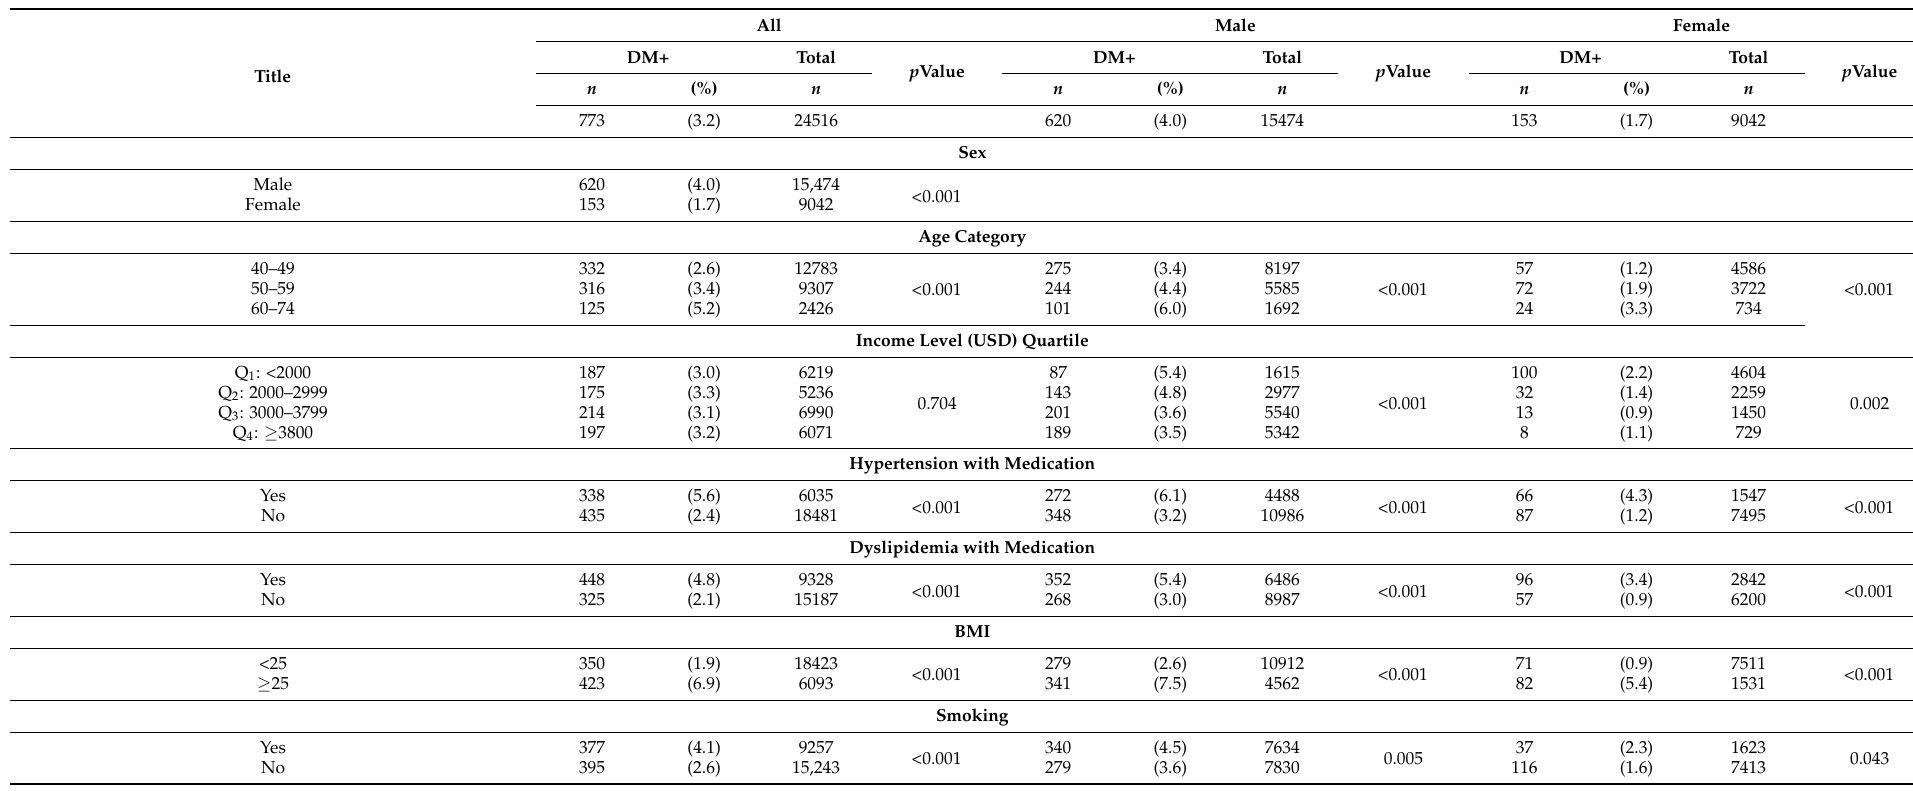
Table 1. Participant